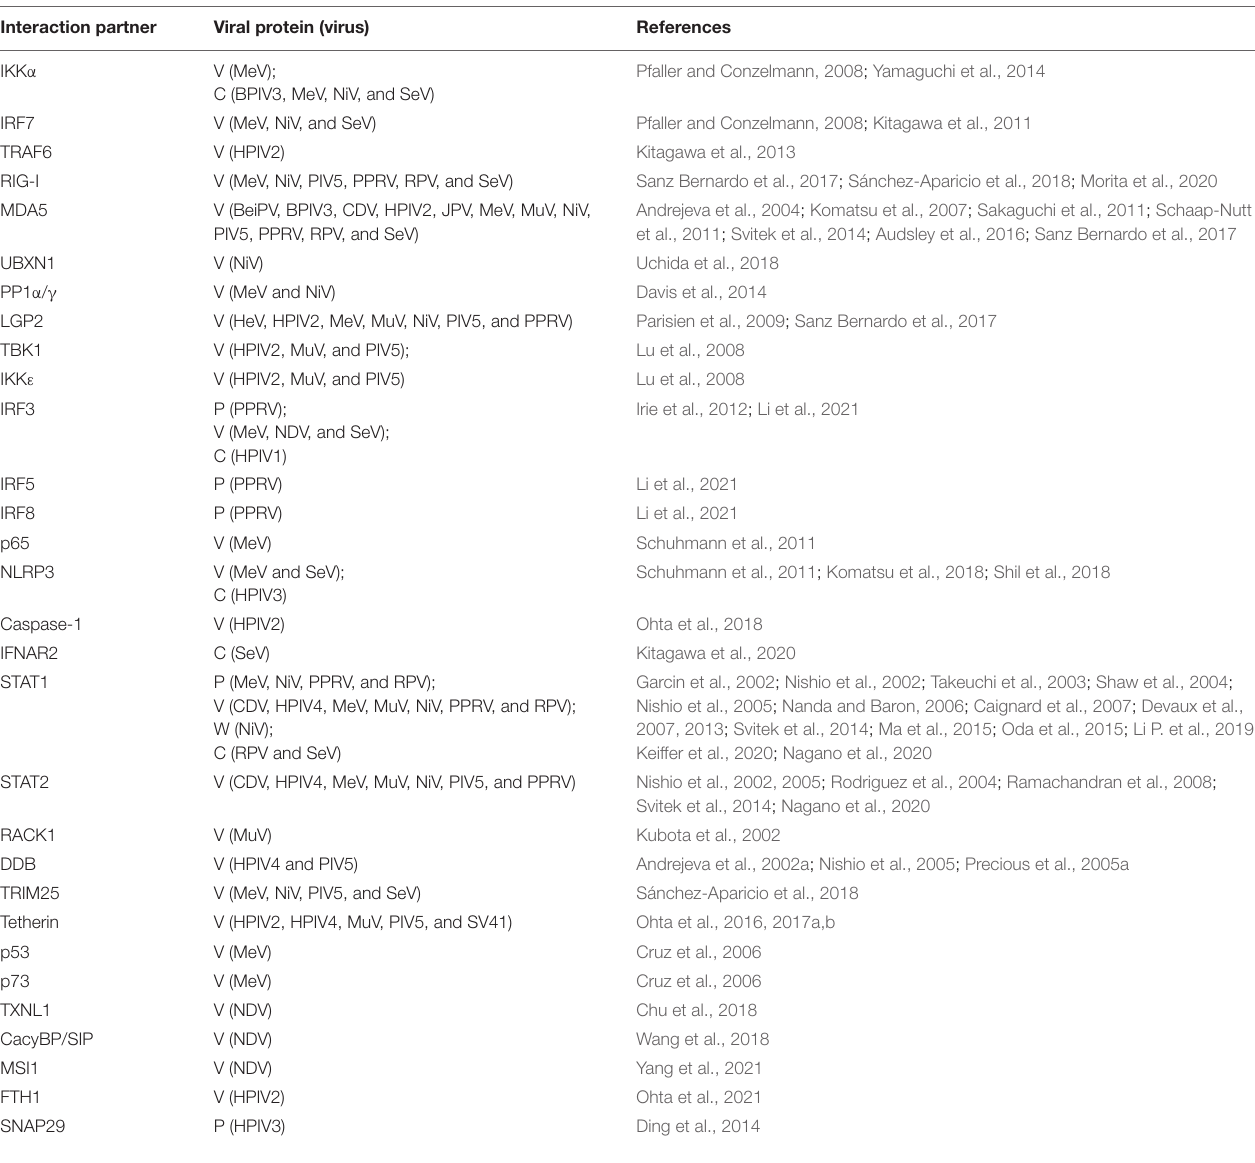
TABLE 1 | List of cellular proteins interacted with paramyxovirus accessory